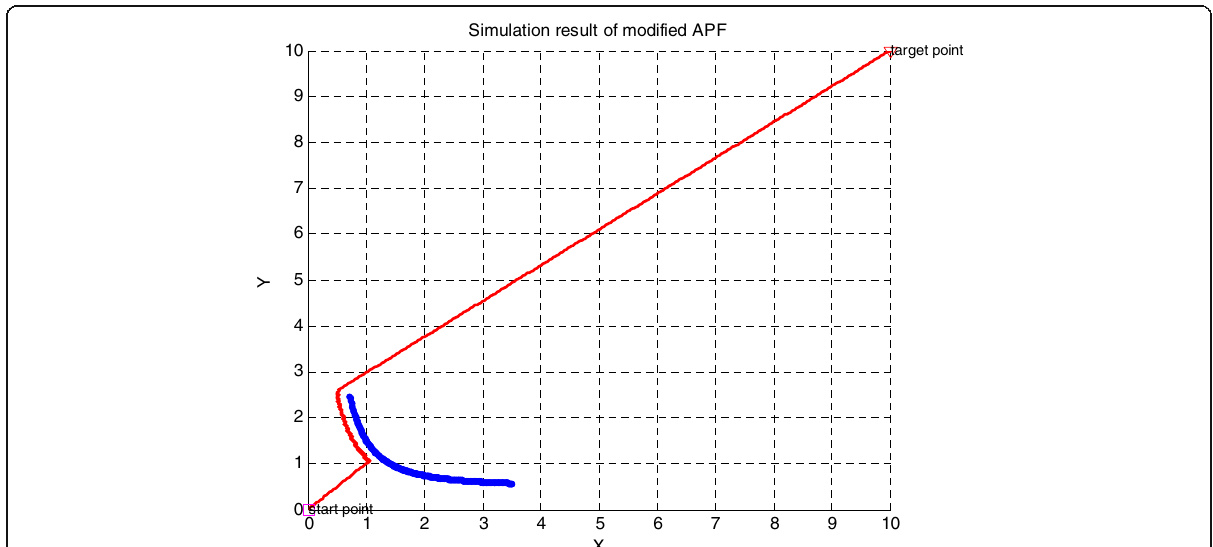
Fig. 20 The result of the curve-shaped obstacle simulation in the modified artificial potential field